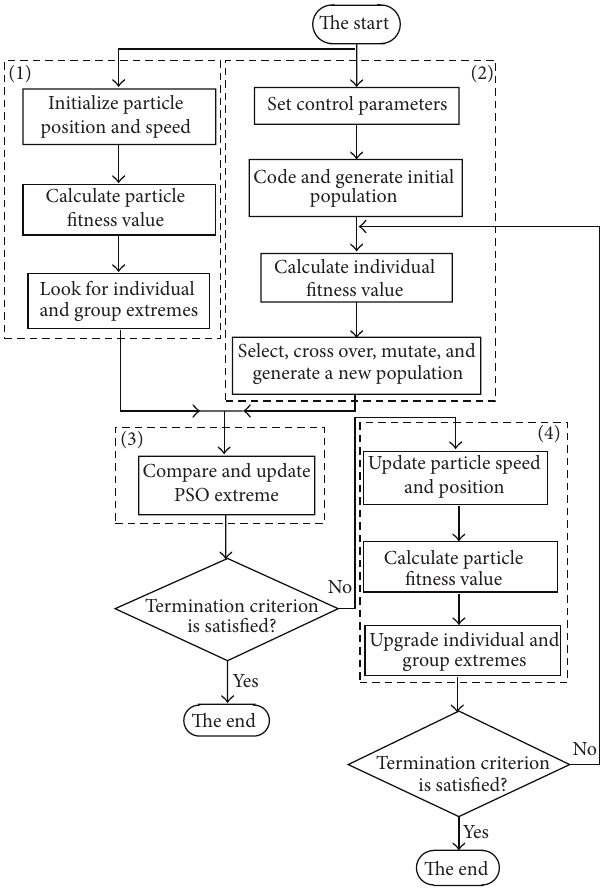
Figure 5: The algorithm process of GA-PSO.